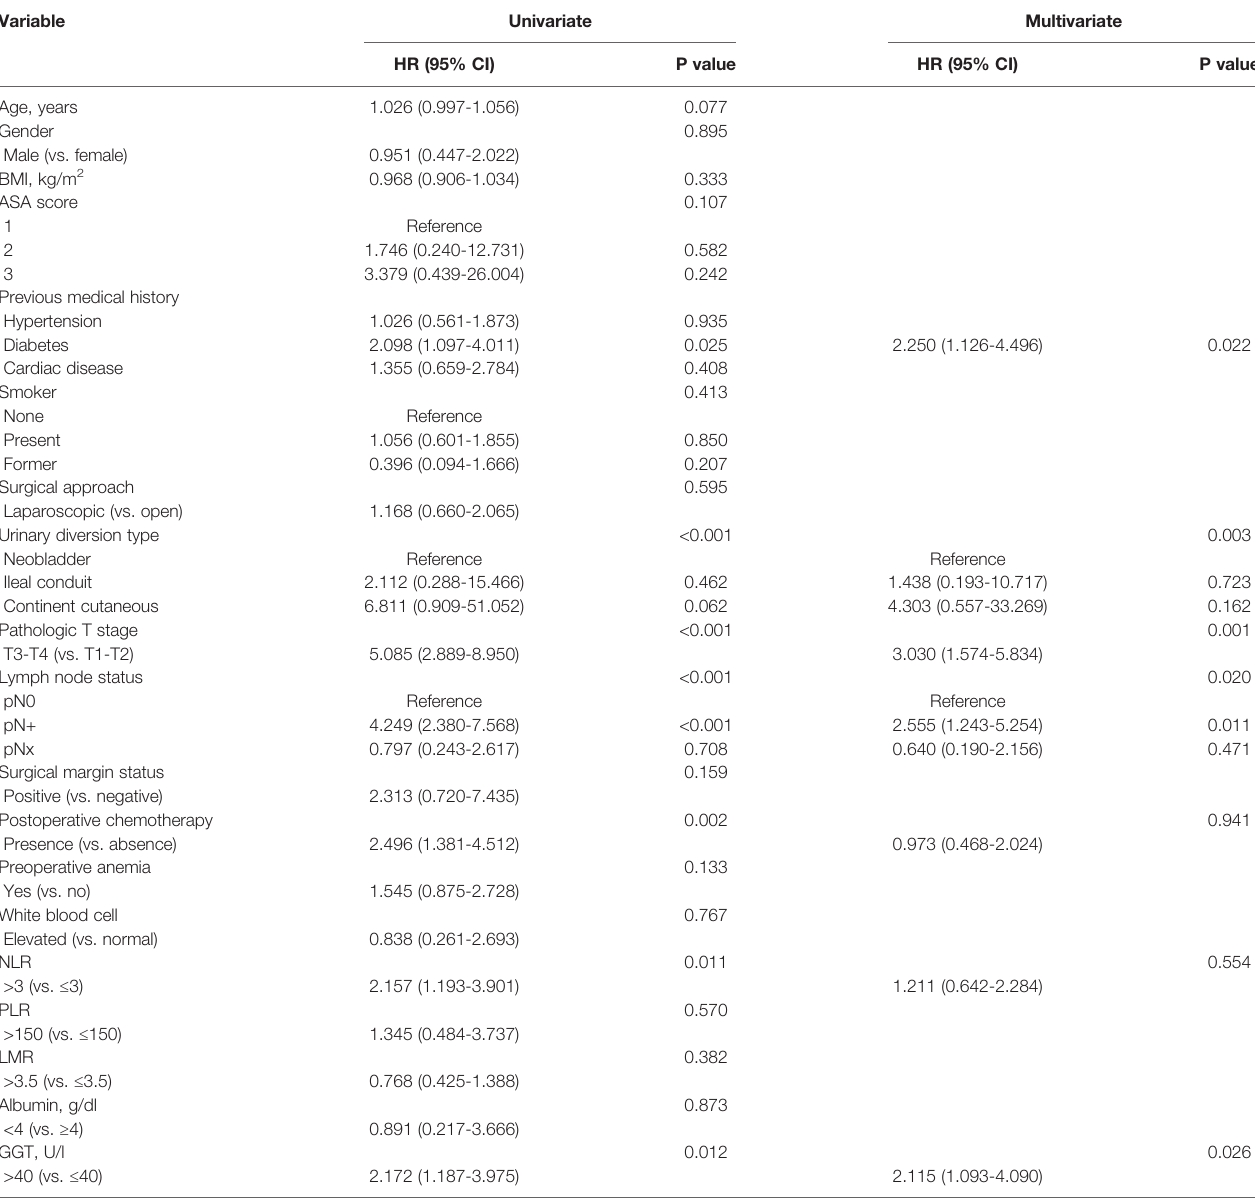
TABLE 3 | Univariate and multivariate analysis for variables predicting cancer-speci fi c survival.